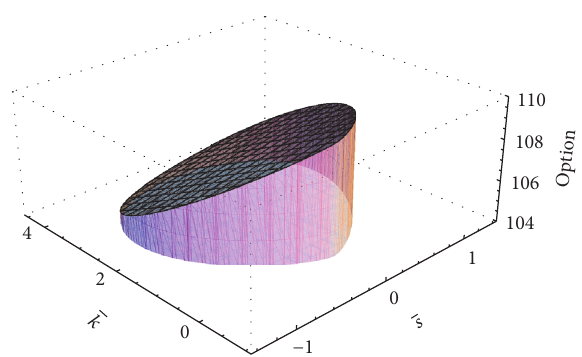
Figure 4: Ratchet premium option prices as a function of skewness and excess kurtosis, with GC (𝑎, 𝑏; 0, 0, 𝑐 3 ,𝑐 4 ) distributions.